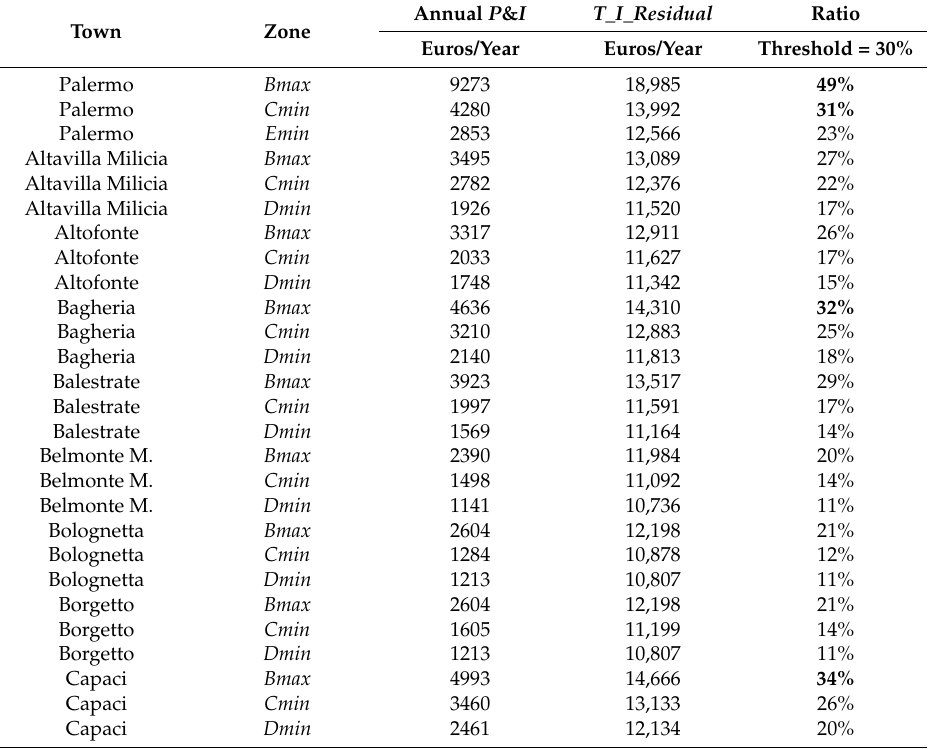
Table 5. Calculation of the T_I_combined in some towns of the NWS area (other data omitted).